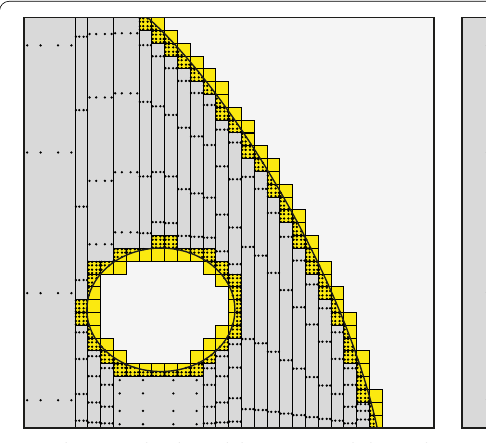
The IPs in the physical domain are scaled accord-a For computing the contribution of Ω ( c ) fict we dis- ing to Eq. (6), while the ones in the fictitious domain tribute n × n IPs in Ω ( c ) and consider only the ones are completely ignored. lying in the fictitious domain (filled black circles) ac- cording to Eq. (6). Fig. 15 Combination of the RFIP approach with the IBR method (IBR ∗ ). This example is based on the compressed set of sub-cells R depicted in Fig. 12b where a 4 × 4-point Gaussian quadrature rule is assumed